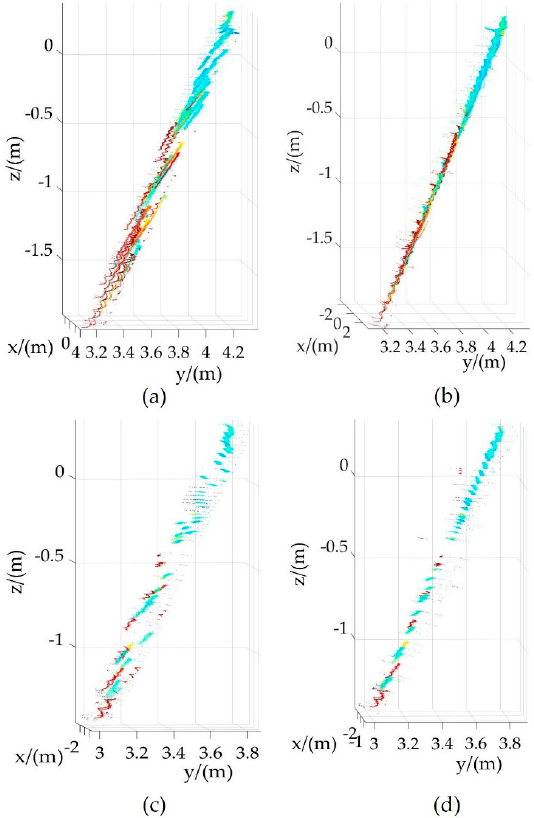
Figure 10. The projection results of the planar point clouds before and after calibration: ( a ) point cloud projection of wall 2 before calibration; ( b ) point cloud projection of wall 2 after calibration; ( c ) point cloud projection of wall 4 before calibration; ( d ) point cloud projection of wall 4 after cali- bration.